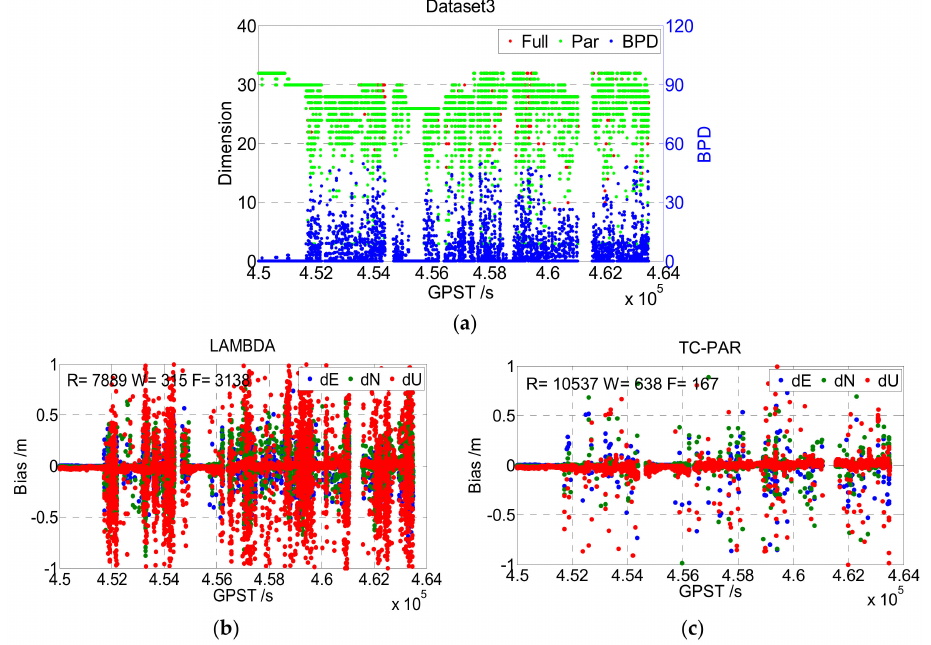
Figure 9. Dimension of ambiguity full set / subset and BPD value ( a ), and the baseline deviation sequence of LAMBDA ( b ) and TC-PAR ( c ) in Dataset3. R, W, and F denote the right fixed epoch, wrong fixed epoch, and float epoch, respectively.